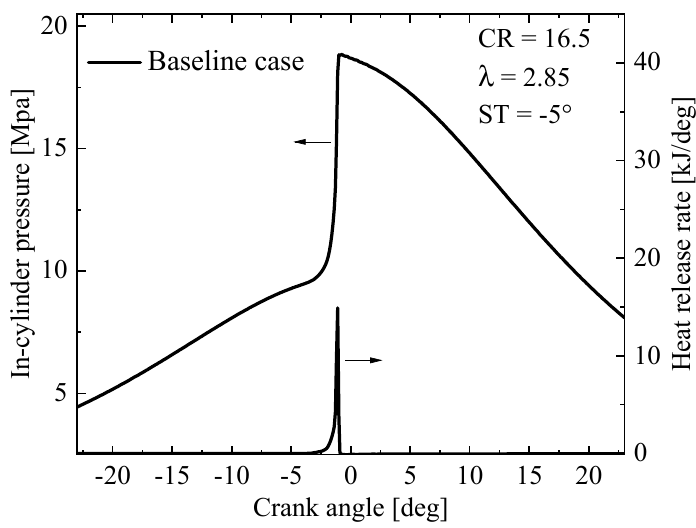
Figure 4. Predicted pressure and heat release rate traces for the baseline case.